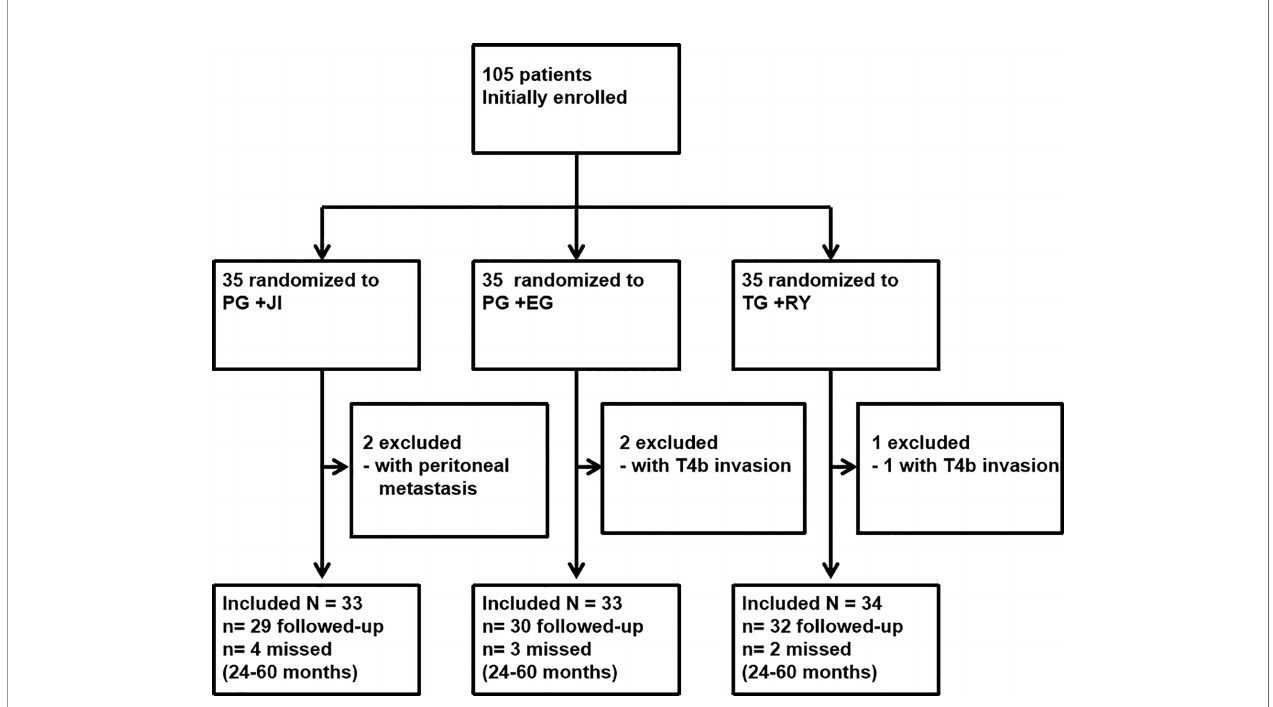
FIGURE 1 | Trial Pro fi